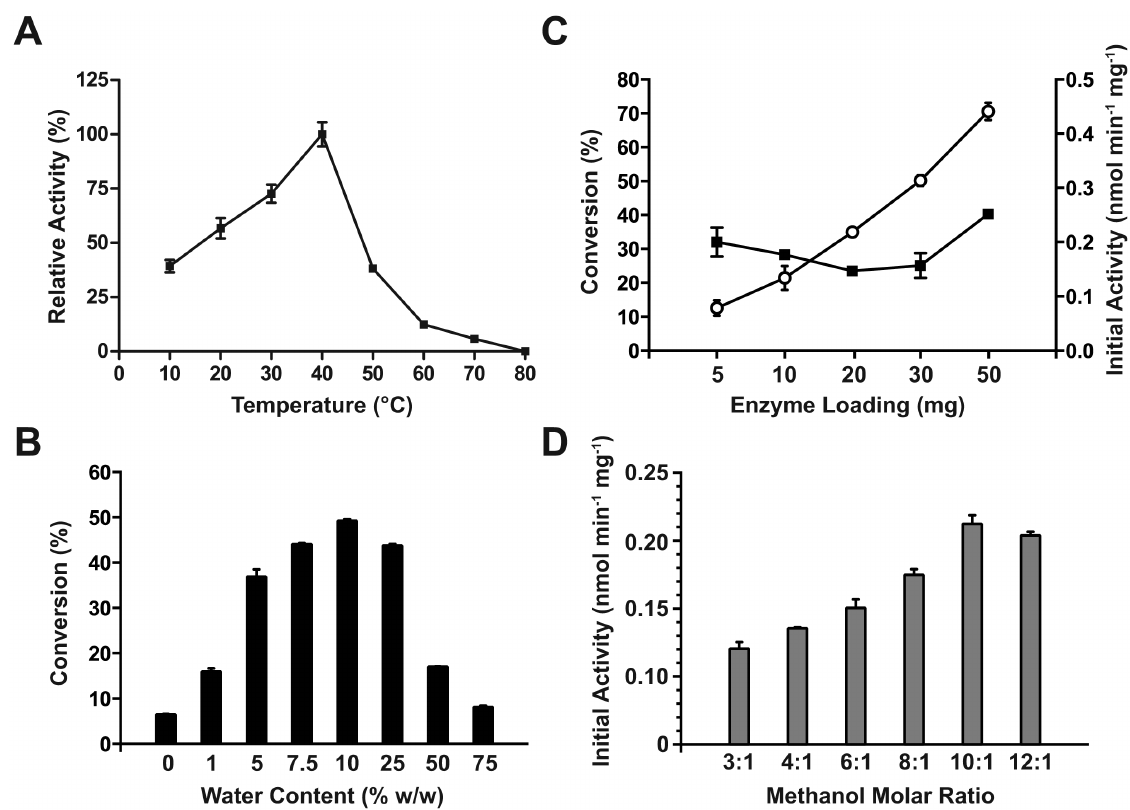
Figure 2. Effect of temperature (A), water content (B), enzyme loading (C), and methanol molar ratio (D) on the LipIAF5-2 WCB activity. A) Effect of temperature on the hydrolytic activity of the LipIAF5-2 WCB. Enzyme activities are expressed relative to maximal activity observed at 40 u C (full squares). B) Effect of water content by percentage of substrate weight. Enzyme activities are expressed as final conversion of 1 mmol of glyceryl tributyrate and 4 mmol of methanol after 6 hours of incubation at 40 u C. C) Effect of enzyme loading on the conversion of 1 mmol of glyceryl tributyrate using 4 molar equivalents of methanol as acyl acceptor in the aforementionned conditions. Conversion of glyceryl tributyrate (open circles) is expressed as final percentage of theoretical maximal yield (3 mmoles of product) after 3 hours of reaction. Initial specific activity (full squares) is expressed as the slope of liberated product determined under linear conditions over a period of at least 30 minutes. Biocatalyst amounts correspond to 1.65, 3.30, 6.61, 9.92 and 16.53% of substrate weight, respectively. D) Effect of alcohol molar ratios on the LipIAF5-2 WCB initial activity. Initial activity was determined in linear conditions over a 3-hour period using 10 mg of WCB, 5% water (w/w), 1 mmol of glyceryl tributyrate and various molar ratios (alcohol/substrate) of methanol in a final volume of 1.5 mL.